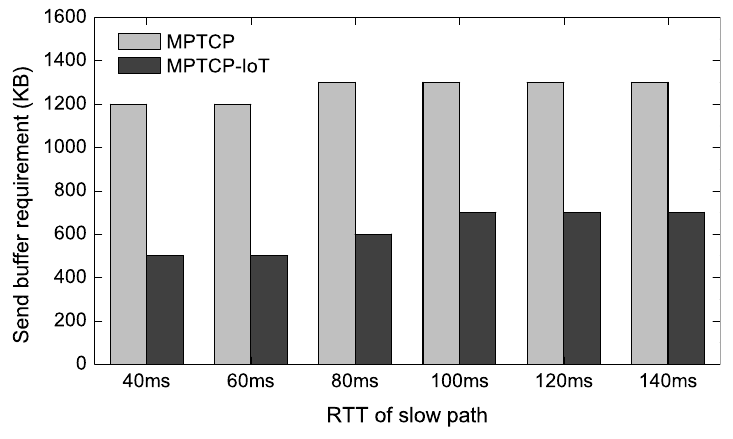
Figure 7. Send-buffer requirement of IoT device.